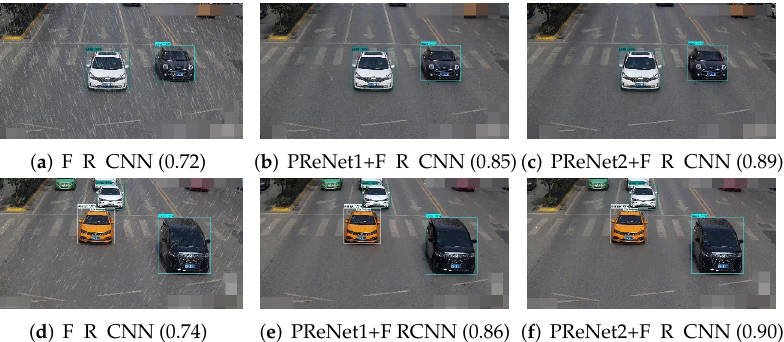
Figure 14. Objective detection test results of Faster R CNN , PReNet 1/2+ Faster R CNN on two syn- thetic rain images with vehicles from the Rain Vehicle Color -24 dataset. Each subtitle is corresponding object detection method and the corresponding confidence value in the parentheses.